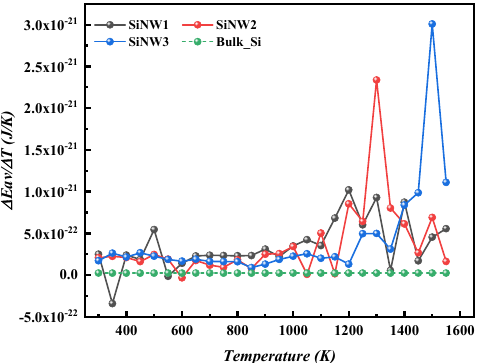
Figure 4. The difference of potential energy per atom as a function of temperatures.